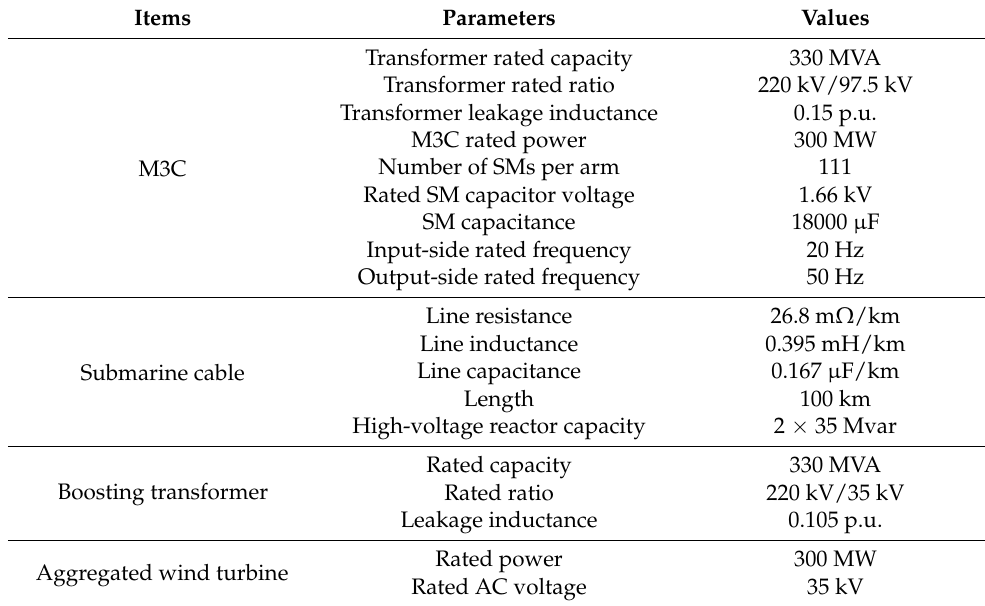
Figure 9. Schematic diagram of test system. Table 2. Main circuit parameters of test